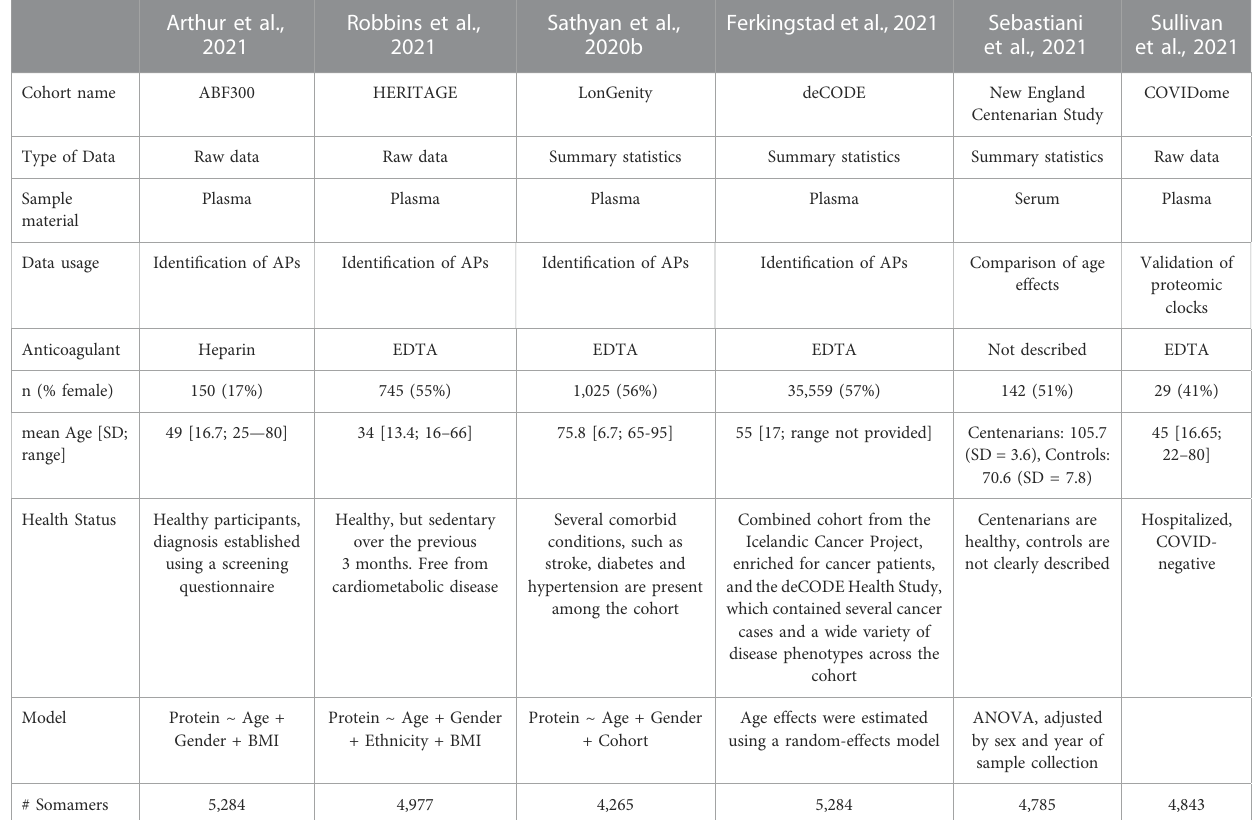
TABLE 1 Overview of included study cohorts for identi fi cation of APs and validation steps. The cohort name, accessibility to raw data or only summary statistics fromtheiranalyses,demographicsonageandsexofthecohorts,usedcoagulantinthestudies,sourcematerial,healthstatusandnumberofmeasuredSomamers are provided. Used models or a description of the model is provided which is used to estimate age effects for each protein individually across each study. Arthur et al.,